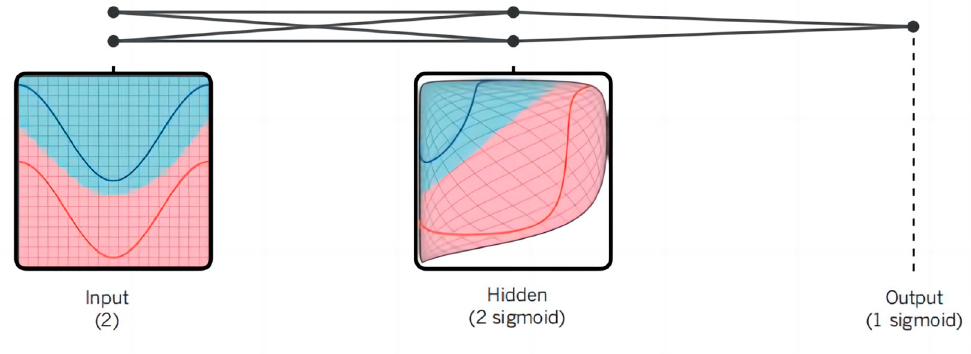
Figure 3. Schematic diagram of multi-layer neural networks in 2015 [53].